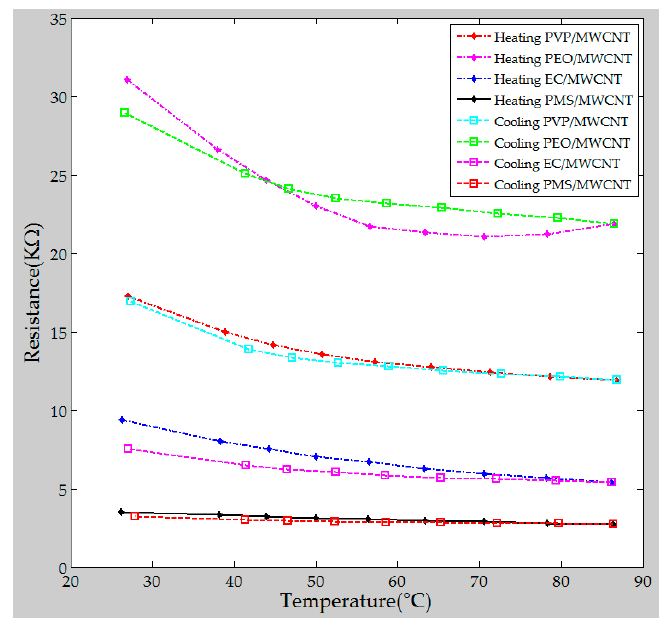
Figure 10. Resistance variation of each polymer/MWCNT composite film with respect to temperature (heating–cooling profile).